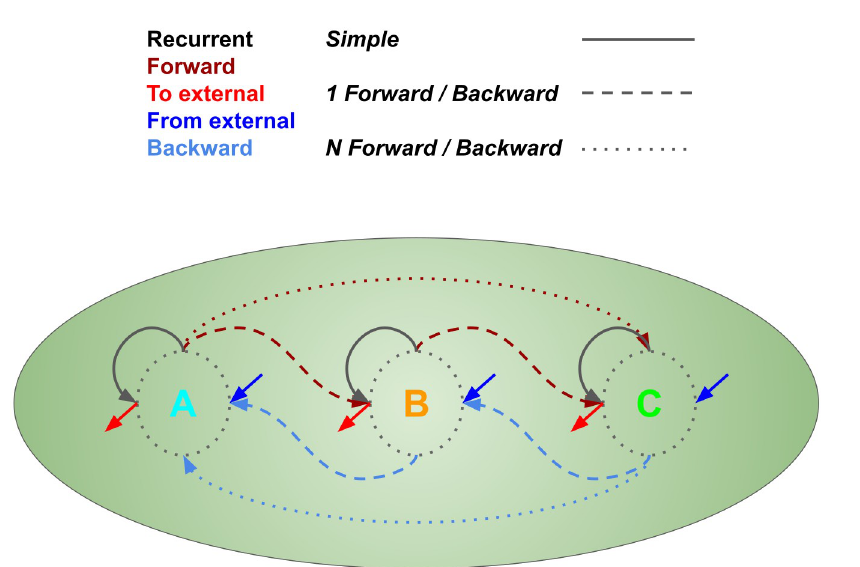
Fig 6. Weight categories. Demonstrative llustration of different weight categories for a simple 3-element sequence. “Recurrent” refers to the recurrent weights within each input cluster. “One forward (backward)” refers to feedforward (feedbackward) weights from one input cluster to the next (to the previous). “N forward (backward)” refers to feedforward (feedbackward) weights between not-immediately-sequential input clusters. “From external” refers to weights going from the background portion of the network to the input clusters, and “To external” refers to weights going from the input clusters to the background portion of the network.